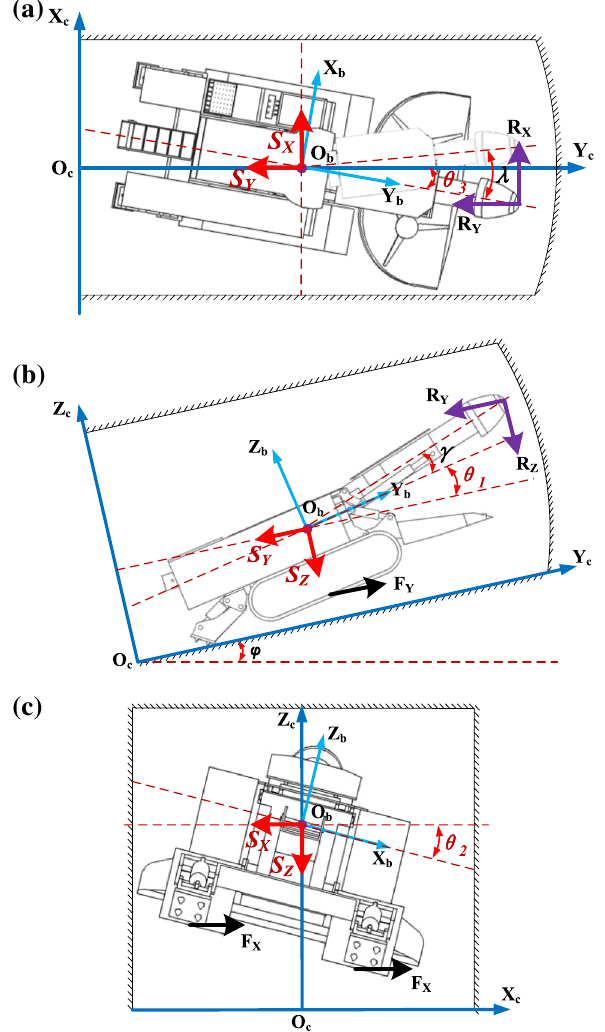
Fig. 1 Mechanical model diagram of roadheader. ( a ) Vertical view; ( b ) Left view; ( c ) Rear